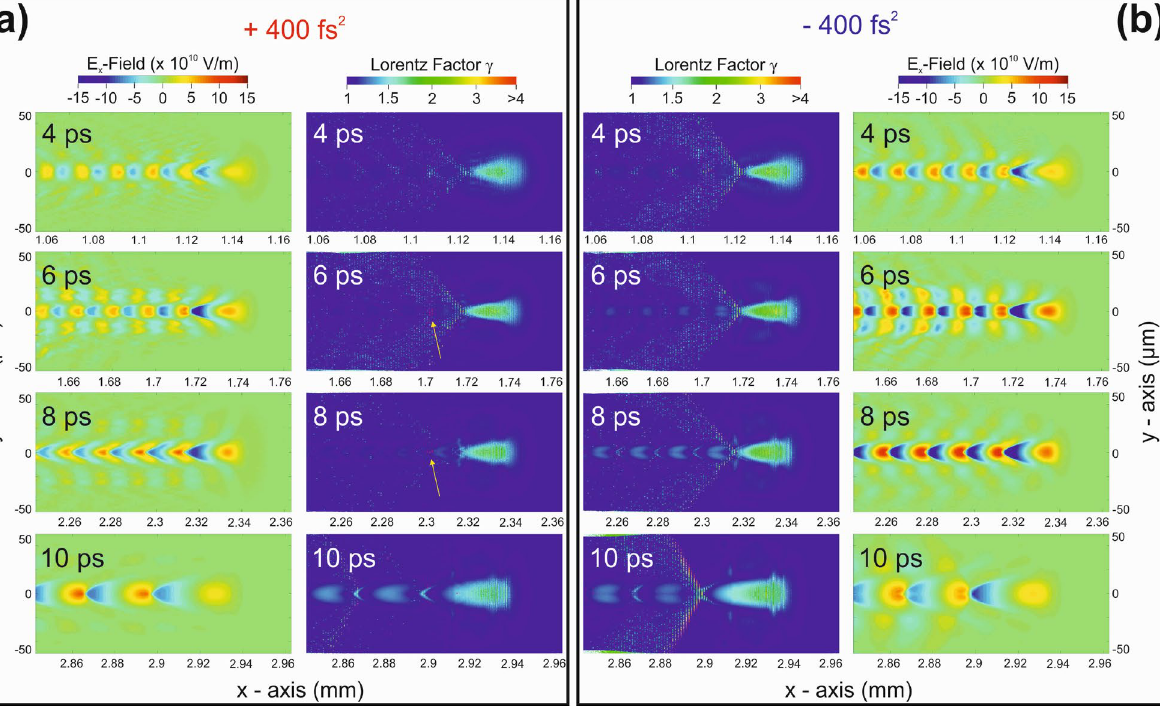
Figure 4. PIC simulation results. ( a ) Spatial distribution of the plasma electric field (left) and the relativistic Lorentz factor, γ , (right) for a chirped laser pulse with chirp value of + 400 fs 2 , obtained at 4, 6, 8, and 10 ps after the simulation was initiated (see text for details). The yellow arrows depict the large γ values at the rear end of the bubble. ( b ) Same as in ( a ) but for a chirped laser pulse with chirp value of − 400 fs 2